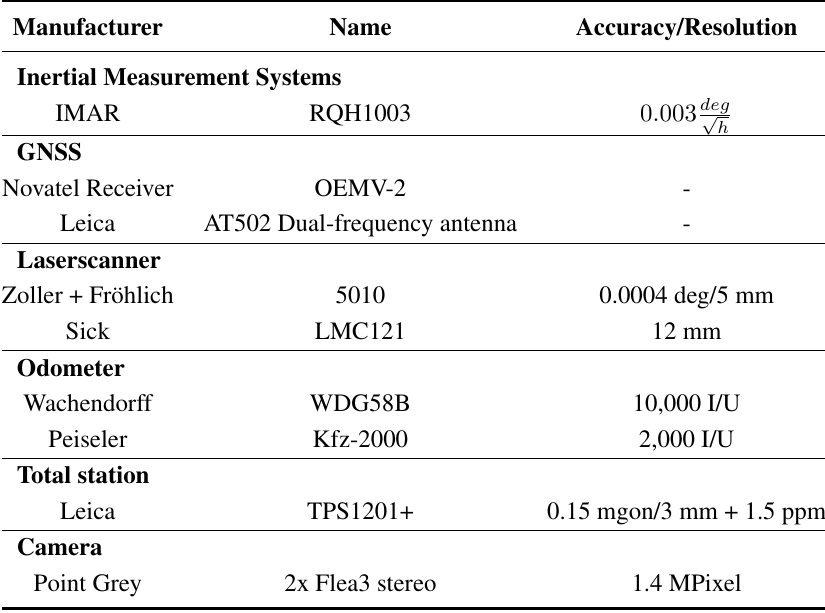
Table 1. Modules of the measurement